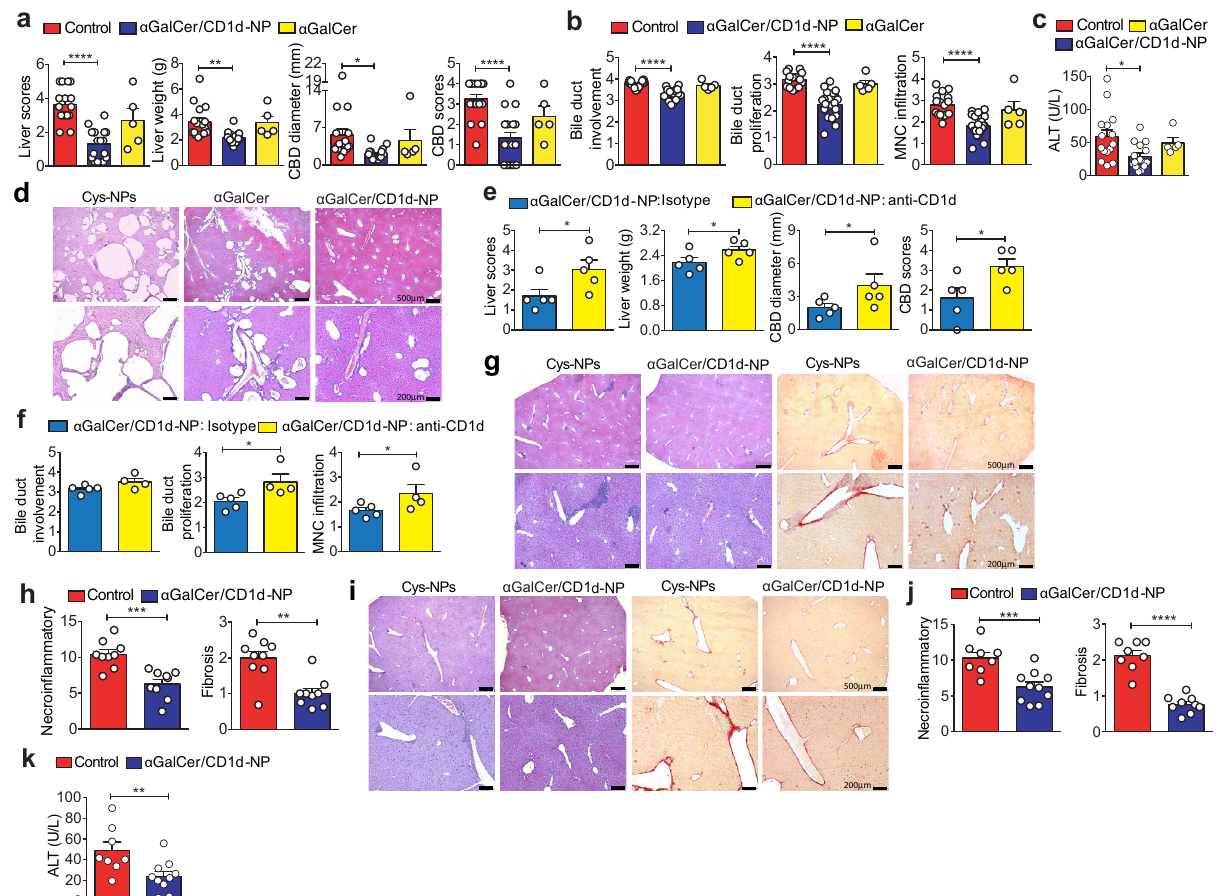
Fig. 1 α GalCer/CD1d-NP-treatment blunts liver autoimmunity. a Macroscopic PBC scores in mice treated with Cys-NPs or left untreated (controls, pooled as no differences were seen between the two: n = 16; treated = 12; untreated = 4; 4 experiments), α GalCer/CD1d-NPs ( n = 18; 4 experiments) or α GalCer ( n = 5). b Microscopic PBC scores corresponding to control NOD. c3c4 mice ( n = 16; treated with Cys-NPs = 12; untreated = 4; 4 experiments), and NOD. c3c4 mice treated with α GalCer/CD1d-NPs ( n = 21; 4 experiments) or α GalCer ( n = 5). c Serum ALT levels in control NOD. c3c4 mice ( n = 16; treated with Cys-NPs = 12; untreated = 4; 4 experiments), and NOD. c3c4 mice treated with α GalCer/CD1d-NPs ( n = 20; 4 experiments). d Representative images of H&E liver sections corresponding to NOD. c3c4 mice from panel b . Scale bars, 500 μ m (top) and 200 μ m (bottom). e , f Average gross ( e ) and microscopic ( f ) PBC scores in NOD. c3c4 mice treated with α GalCer/CD1d-NPs and rat IgG1 isotype or anti-CD1d mAb ( n = 5 in each group). g , h Representative images of H&E- and Picrosirius Red-stained liver sections ( g ) and average microscopic PBC scores ( h ) for (NODxB6. Ifng-ARE-Del – / – ) F1 mice treated with Cys-NPs ( n = 9; 3 experiments) or α GalCer/CD1d-NPs ( n = 9; 3 experiments). Scale bars, 500 μ m (top) and 200 μ m (bottom). i , j Representative images of H&E- and Picrosirius Red-stained liver sections ( i ) and average microscopic AIH scores ( j ) from NOD mice with Ad-FTCD- induced AIH, treated with Cys-NPs ( n = 8; 2 experiments) or α GalCer/CD1d-NPs ( n = 10; 3 experiments). Scale bars, 500 μ m (top) and 200 μ m (bottom). k , Serum ALT levels ( n = 8 and 10, treated with Cys-NPs and α GalCer/CD1d-NPs, respectively. Data are represented as means± SEM and were compared using one-way ANOVA with Tukey ’ s multiple comparison test ( a – c ) or one tail Mann – Whitney U test ( e , f , h , j , k ). * P < 0.05; ** P < 0.01; *** P < 0.001; **** P < 0.0001. iNKT10 1,4,5,9,10,31,32 , lymph node FoxP3 + iNKT 33,34 , follicular- expression levels of the iNKT cell subset-de fi ning genes listed helper iNKT 35 , adipose-tissue-resident iNKT 9,36 , or Breg-induced in Table 1 1,4,5,9,10,31 – 37 were similar among the three strains iNKT cells 37 (Table 1). (Supplementary Fig. 1e). Therefore, the LiNKT cells from NOD.c 3c4 , NOD, and B6 mice express a unique transcriptome.